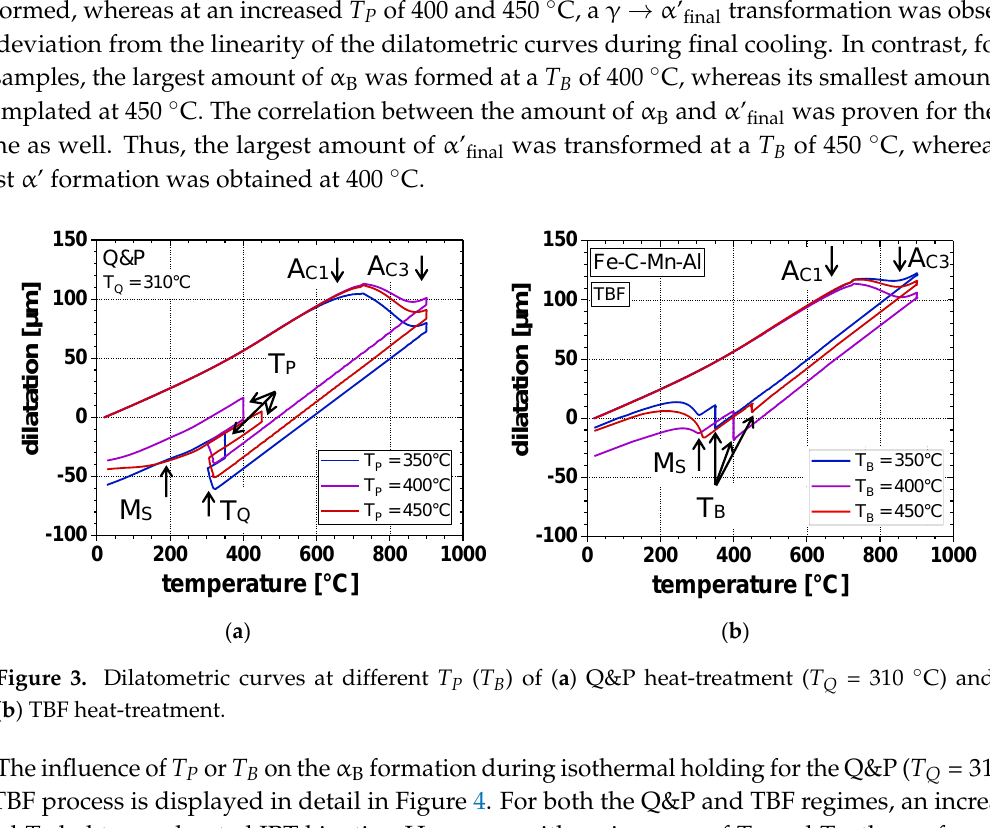
Figure 3. Dilatometric curves at different T P ( T B ) of ( a ) Q&P heat-treatment ( T Q = 310 °C) and ( b ) TBF heat-treatment.